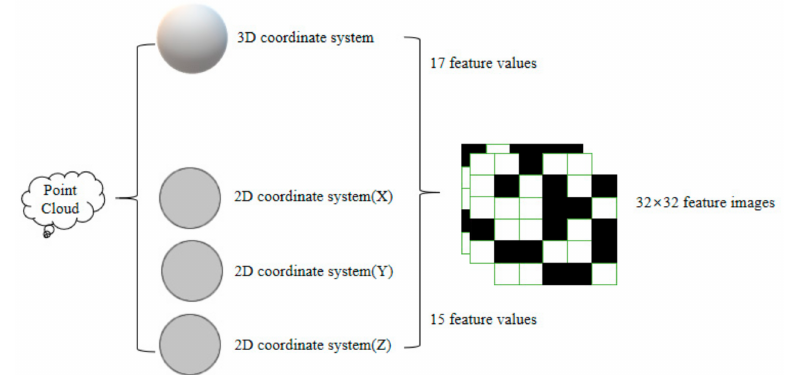
Figure 1. Generation of point cloud feature